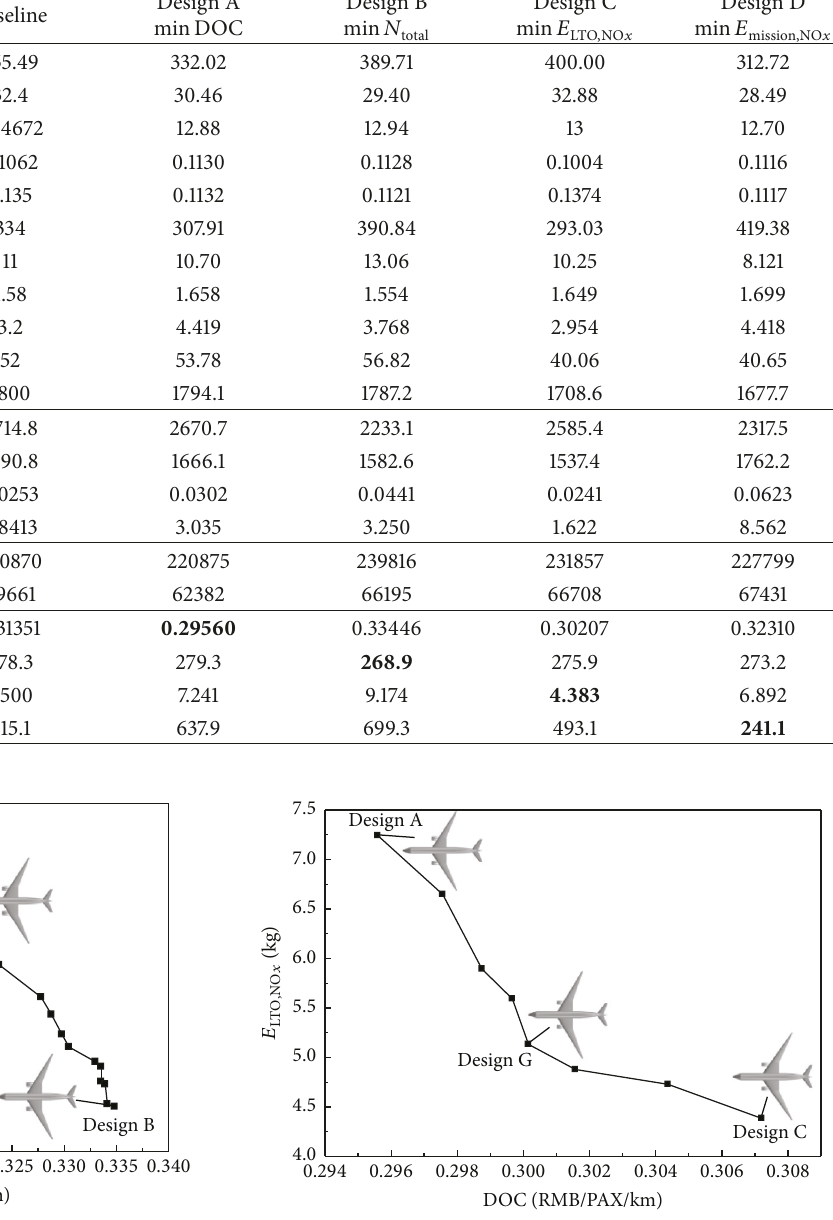
at the left most point, and design B (minimum total noise) at the far right. Design F is the intermediate solutions in the Figure 10. It can be seen that the total noise decreased slowly with the increase of DOC from design A to design F. But from design F to design B, the reduction rate of the total noise is steeper with the increase of DOC compared with the left half segment. From design A (minimum DOC solution) to design B (minimum noise solution), the total noise decreases by 10.4 dB while DOC increases by